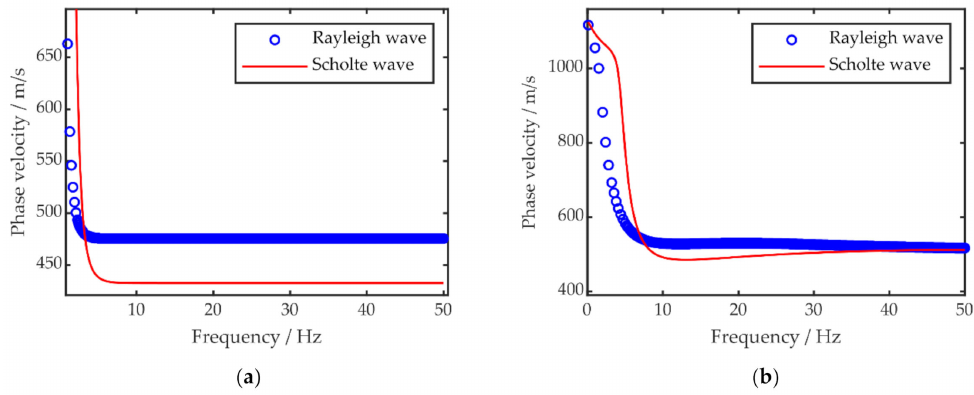
Figure 4. Fundamental mode dispersion curve of Model 1 ( a ) and Model 2 ( b ). The red solid line is the Scholte wave dispersion curve and the blue circles are the Rayleigh wave dispersion curve of the models removing the water